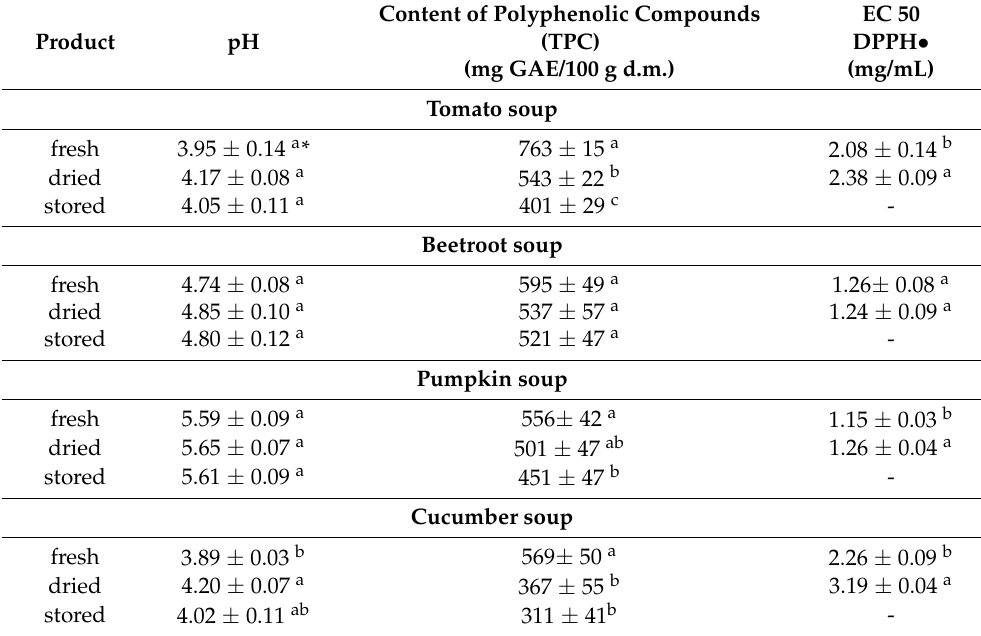
Table 6. Selected biochemical properties of different fresh, freeze-dried, and stored